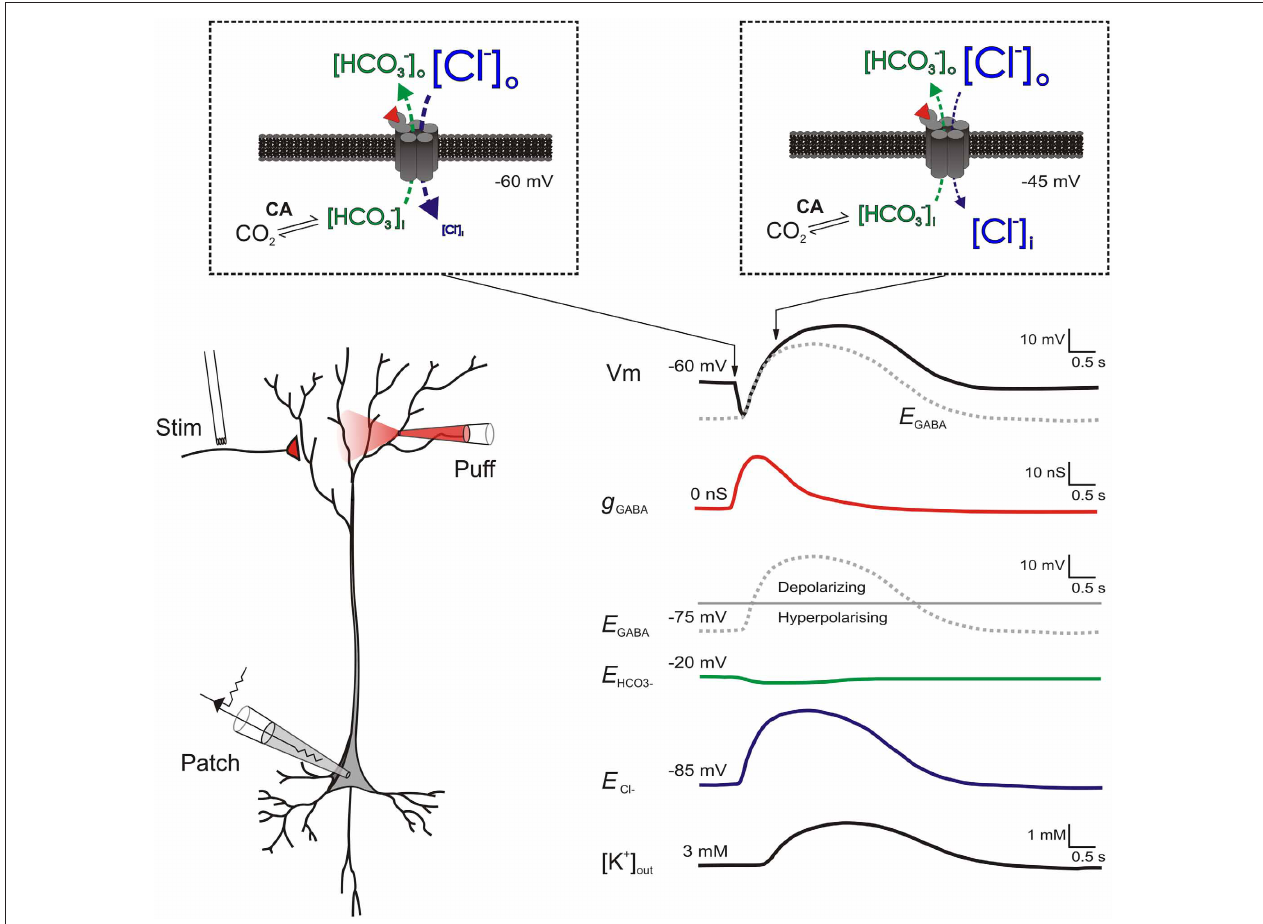
FIGURE 1 | Biphasic responses to intense GABA A R activation are caused arrow) while HCO − 3 flows out (green arrow). As GABA A Rs are approximately by a rapid shift from hyperpolarizing to depolarizing E GABA . (Left) a four times more permeable to Cl − than to HCO − 3 ions (Kaila and Voipio, schematic of a patched pyramidal neuron receiving strong GABA A R input 1987), the bulk of anion flux through the receptors is Cl − . This causes the either via stimulation of GABAergic afferents or application of GABA. (Right) membrane potential hyperpolarization typical of classic GABA A R mediated inhibition. With continued GABA A R activation (right inset), Cl − influx traces showing the putative changes in ionic and synaptic parameters as a ultimately exceeds Cl − extrusion mechanisms and a reduction in the result of the GABA A R activation. Separate traces show the cell’s membrane potential (Vm, black); the GABA A R conductance (g GABA , red), the reversal transmembrane Cl − gradient occurs (Staley and Proctor, 1999). A , green) and potentials for the GABA A R ( E GABA , gray dashed), HCO 3 − ( E HCO corresponding depletion of intracellular HCO − 3 is prevented by the activity of 3 chloride ( E Cl − , blue); plus the extracellular K + concentration ([K + ] out , black). carbonic anhydrase, which uses CO 2 as a substrate to rapidly regenerate Insets (within dashed boxes) show transmembrane ion fluxes and gradients HCO − 3 (Rivera et al., 2005). As a result, E Cl − (blue trace) and hence E GABA shift toward the more positive E HCO − (green trace) causing the membrane at two points during the response to GABA A R activation. At the start of 3 GABA A R activation (left inset) [Cl − ] is typically much higher outside neurons depolarization typical of the biphasic GABAergic response. Intracellular Cl − (e.g., 135mM) as opposed to inside neurons (e.g., 6mM). In contrast, accumulation also results in the delayed extrusion of K + into the extracellular [HCO 3 − ] is only moderately higher outside (23mM) as compared to inside space via the Cl − /K + cotransporter KCC2. This further contributes to the (12mM). Therefore at a typical resting membrane potential of − 60mV, when late-stage depolarization of the biphasic response (Kaila et al., 1997; Viitanen GABA (red wedge) binds to ionotropic GABA A Rs, Cl − flows into the cell (blue et al.,